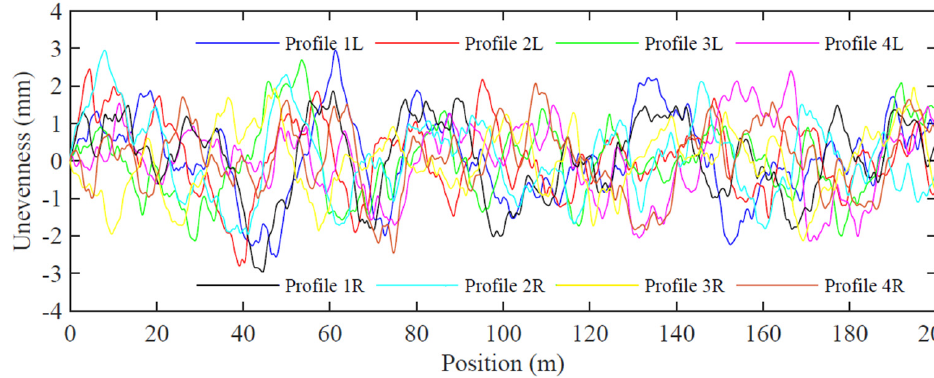
Figure 3. Longitudinal irregularity profiles (1-4) for left and right rails.